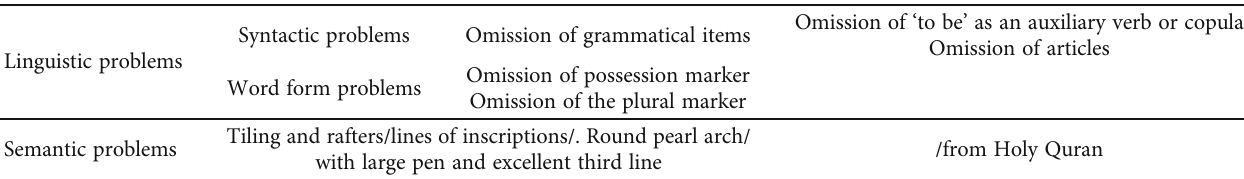
Table 4: Linguistic and semantic problems of English translation of the pearl arch